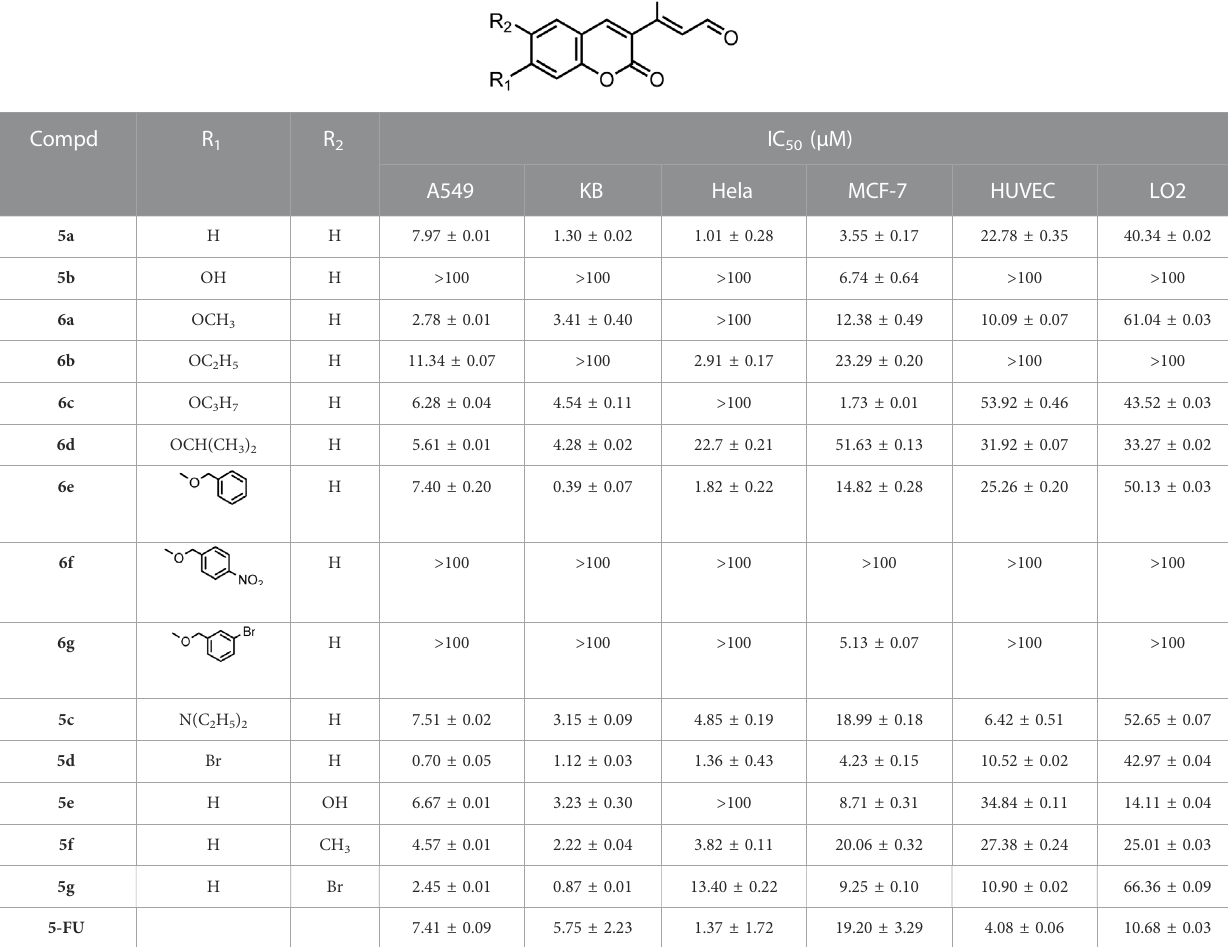
TABLE 1 Antiproliferative activities of compounds 5a - g and 6a - g against different cancer cell lines and human normal cell lines.